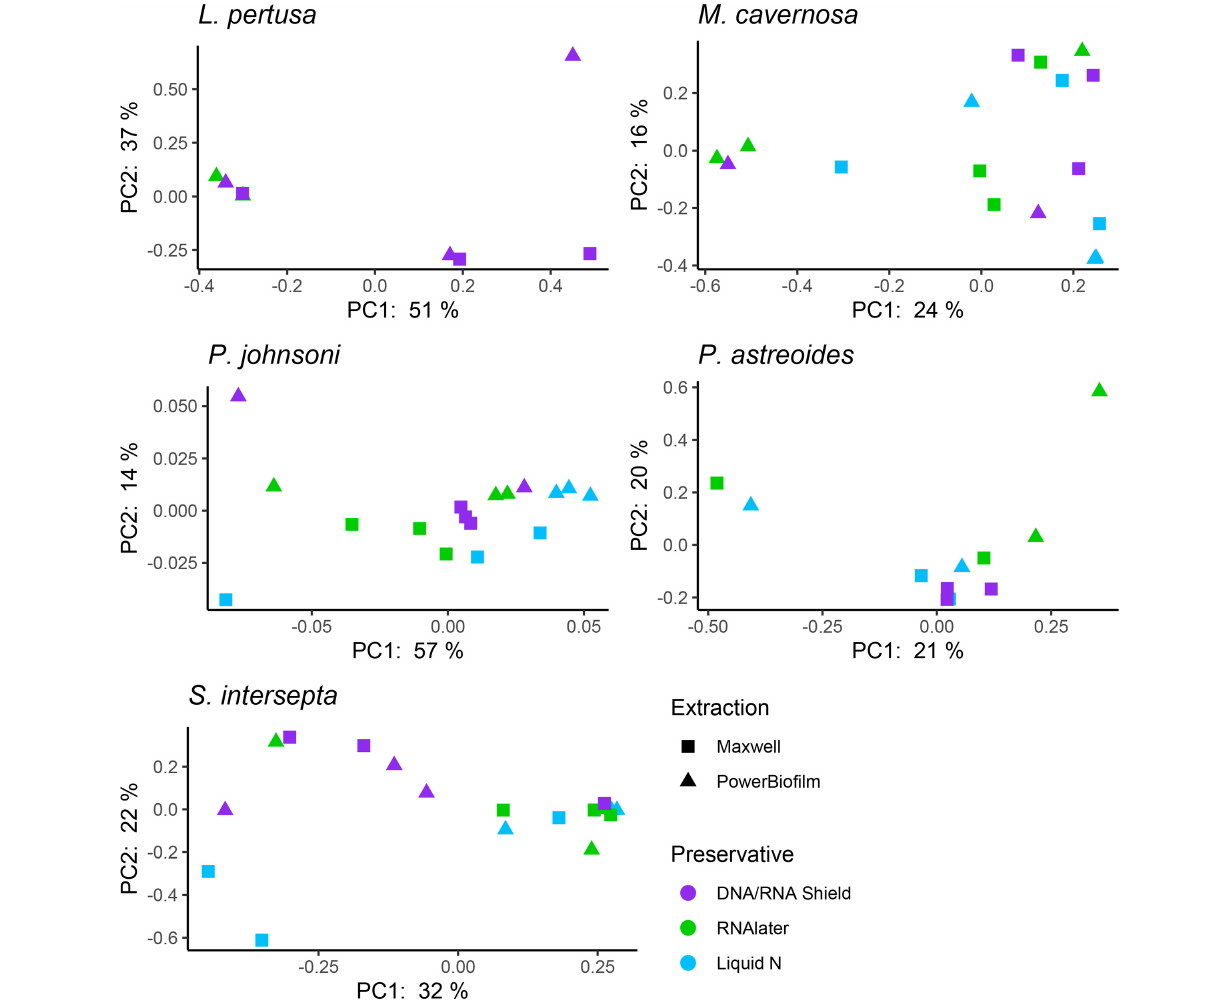
FIGURE 3 | Principal coordinate plots based upon a Bray–Curtis dissimilarity matrix of individual coral species Lophelia pertusa , Paragorgia johnsoni, Montastraea cavernosa , Porites astreoides , and Stephanocoenia intersepta. Strong clustering is not observed for preservative or extraction, but some significant differences were detected through an analysis of similarities (ANOSIM; Table 5